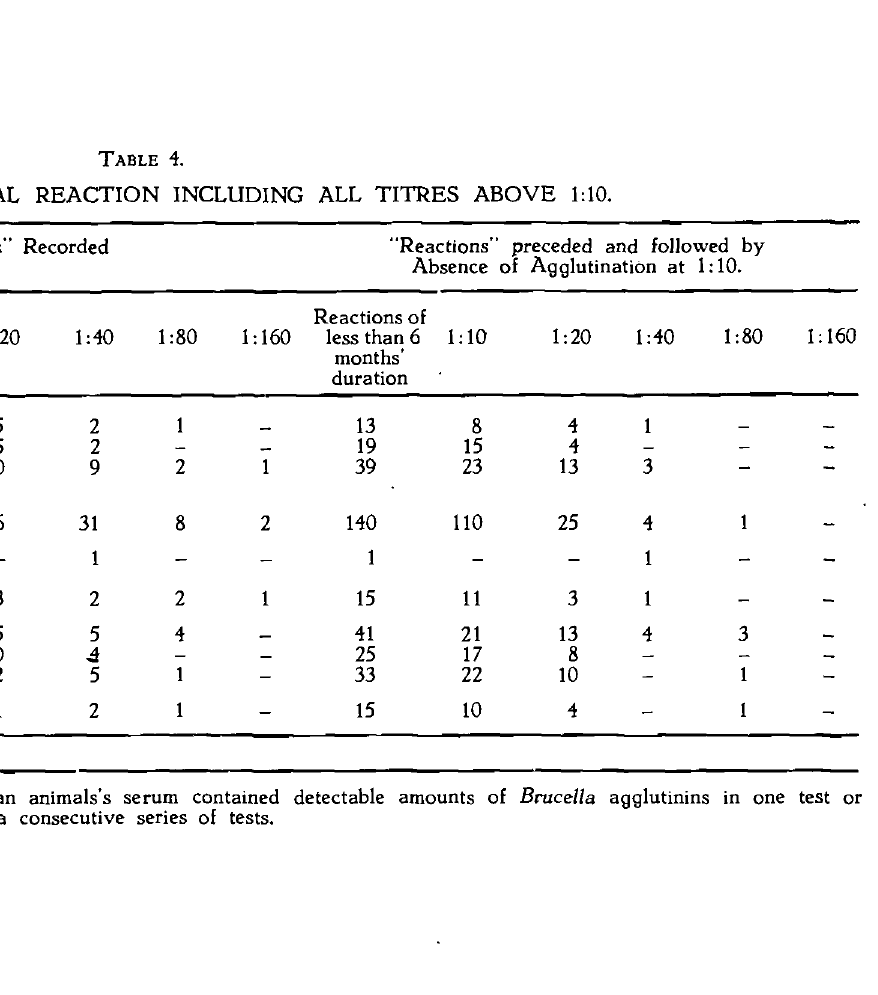
SUMMARY OF SEROLOGICAL REACTION INCLUDING ALL TITRES ABOVE